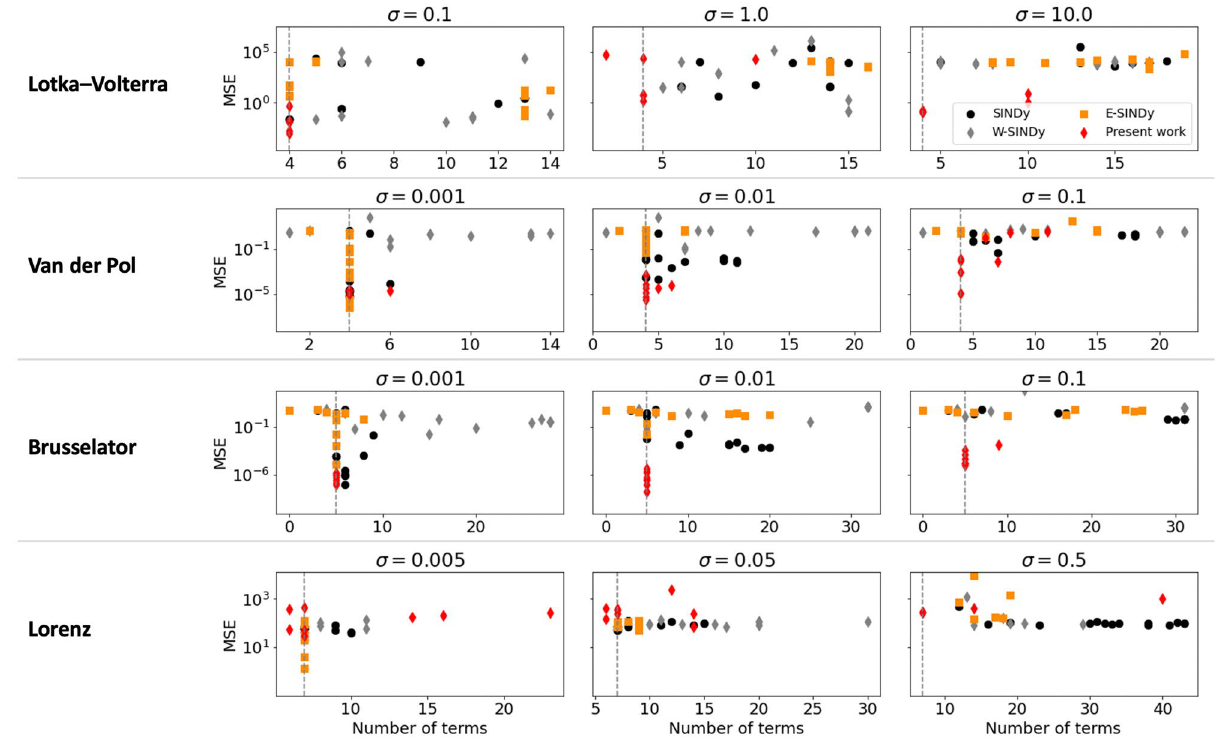
Figure 3. Benchmarking experiments of the proposed framework against the SINDy family of methods. The results shown correspond to the discovered model’s complexity (reflected in the number of terms) versus the model’s predictive ability (reflected in the mean squared error). Each marker corresponds to a specific instance of a given method for a given set of hyperparameters(see Supporting Information for associated values used). The dashed vertical line indicates the number of terms present in the true governing equation for each